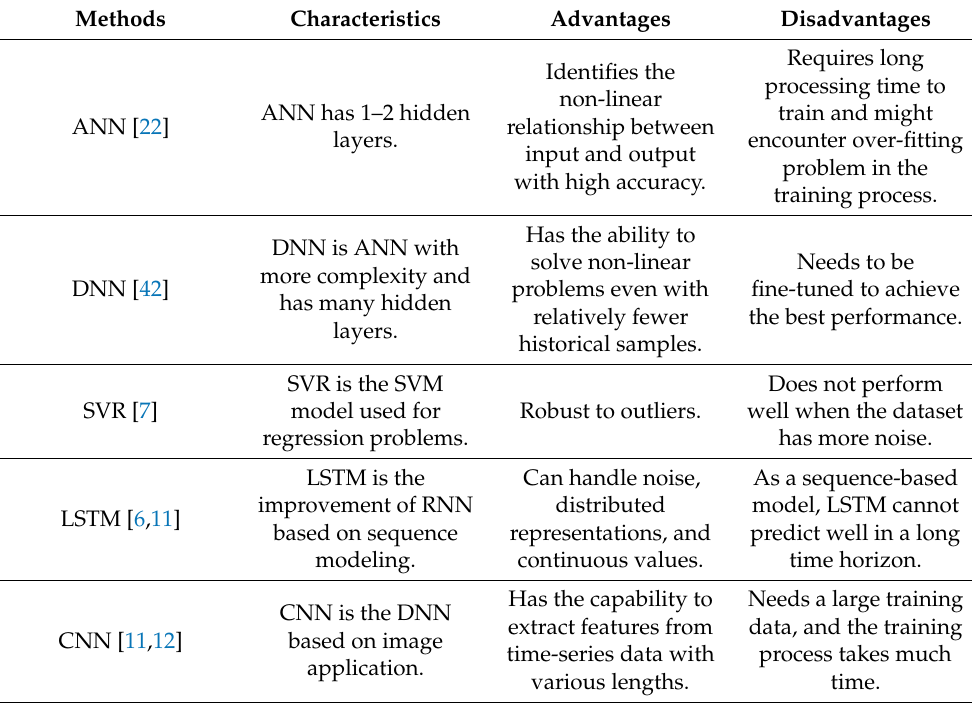
Table 1. Summary of the single learner methods